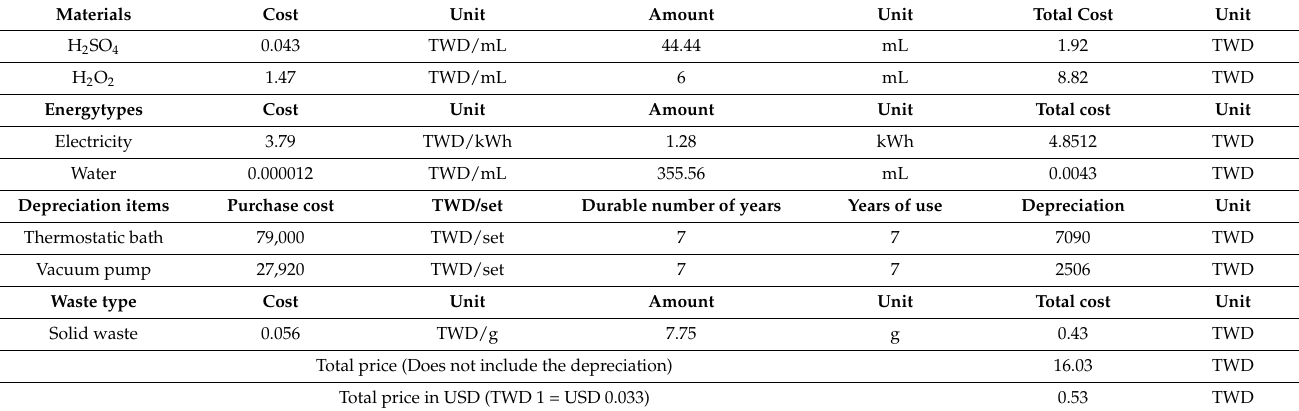
Table 7. Sulfuric acid leaching cost.